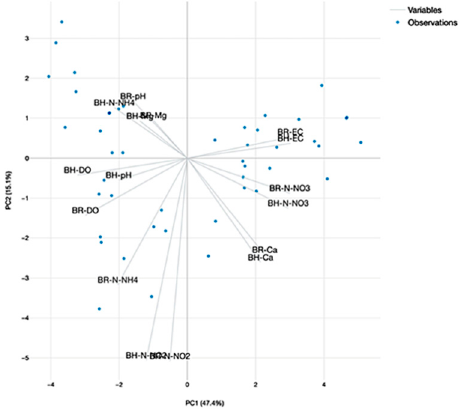
Figure 29. The PCA for water quality parameters associated to B dataset.